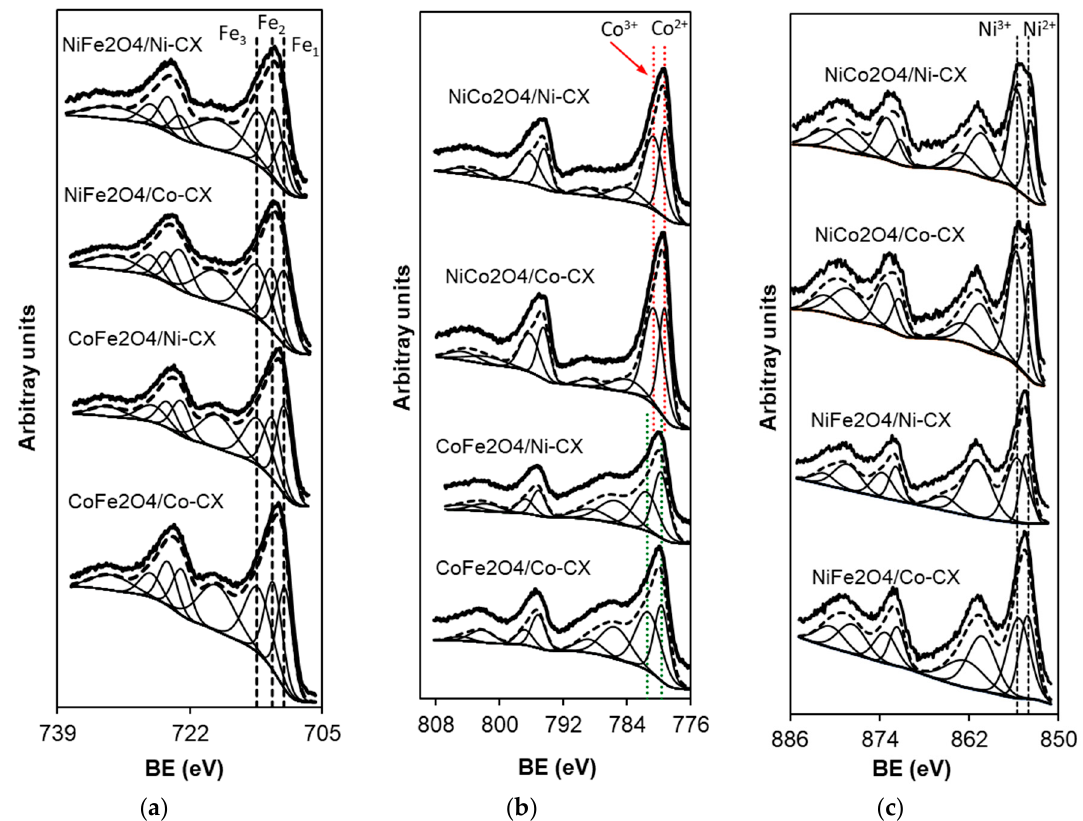
Figure 5. Deconvolution of the XP spectra for the prepared materials. ( a ) NiFe 2 O 4 and CoFe 2 O 4 doped carbon xerogels, ( b ) NiCo 2 O 4 and CoFe 2 O 4 doped carbon xerogels and ( c ) NiCo 2 O 4 and NiFe 2 O 4 doped carbon xerogels.